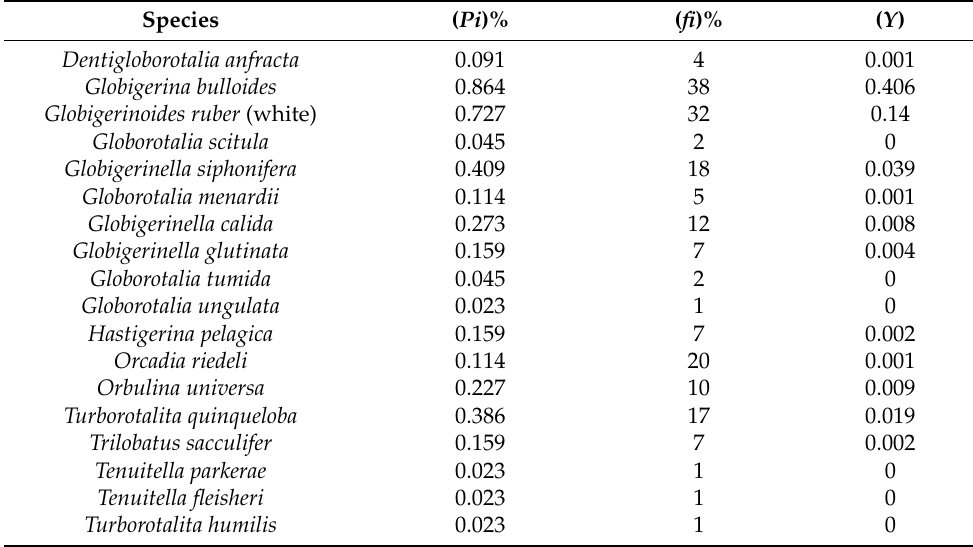
Table 1. Relative abundance ( Pi ), occurrence/frequency ( fi ), and dominance indices of ( Y ) foraminifera species in the survey area. Note that Y is the dominant index from abundance.